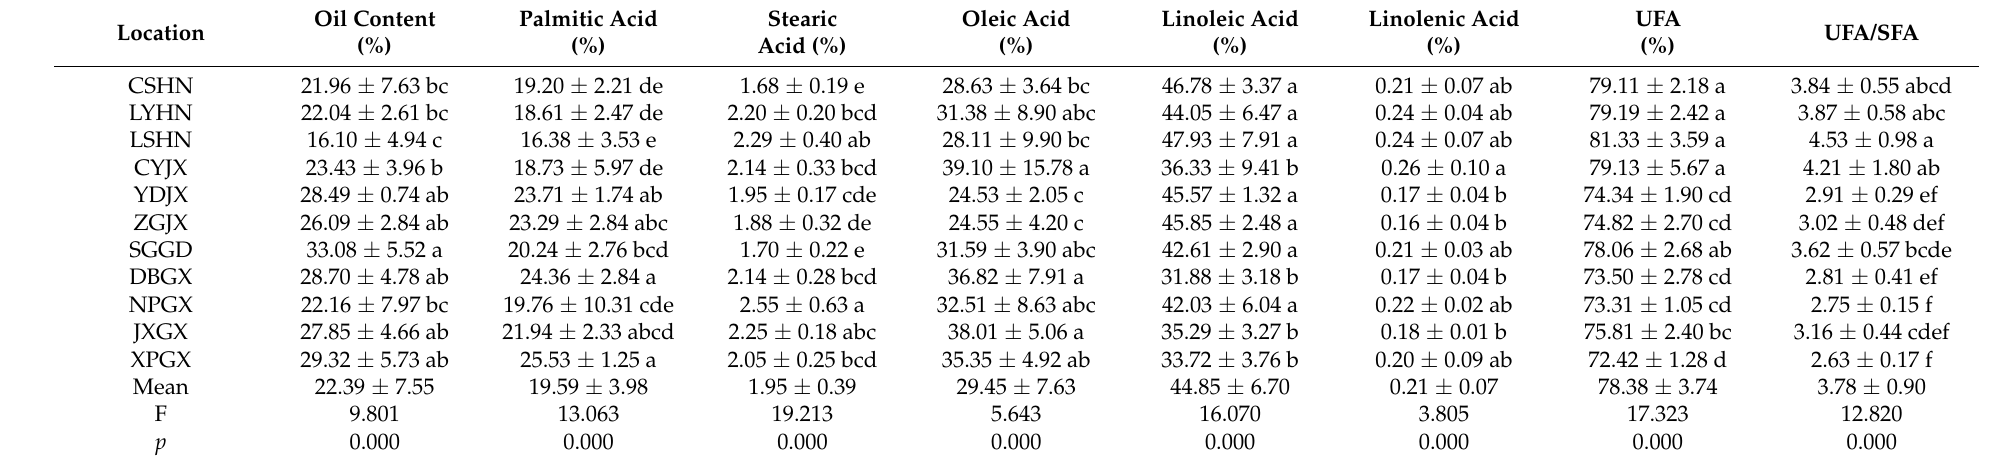
Table 3. Oil content and fatty acid composition of different S. wilsoniana fruit